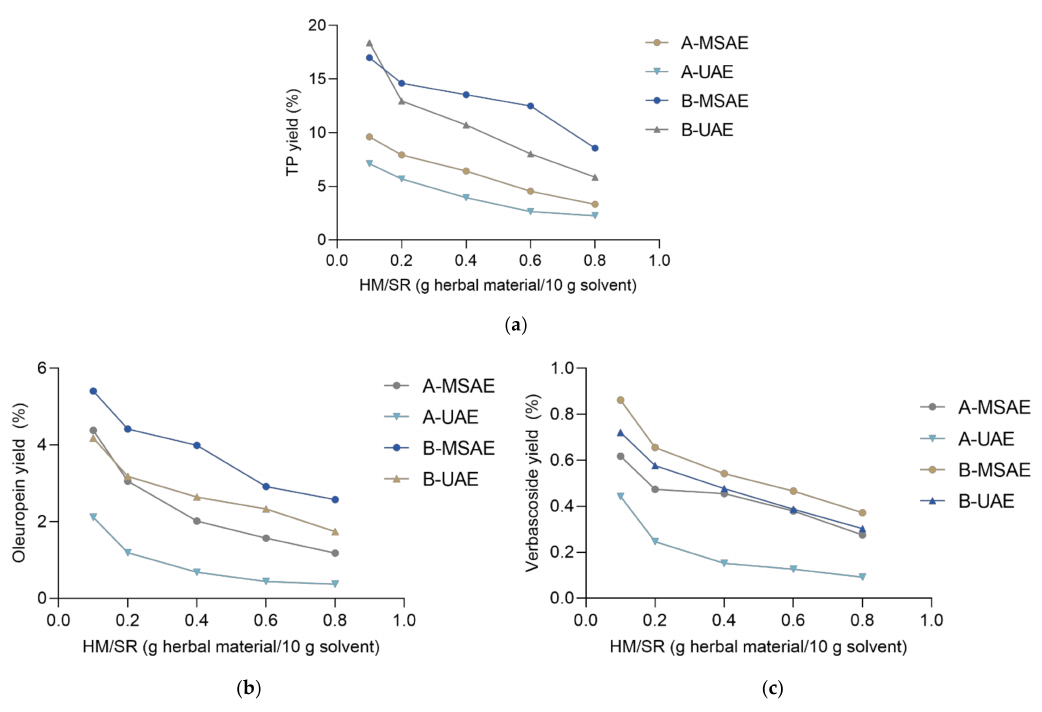
Figure 3. The relationship between the HM/SR (herbal material/solvent ratio) and the yield (%) for ( a ) total phenol (TP), ( b ) oleuropein, and ( c ) verbascoside content. A, B denote the extraction solvent; UAE, MSAE denote the extraction